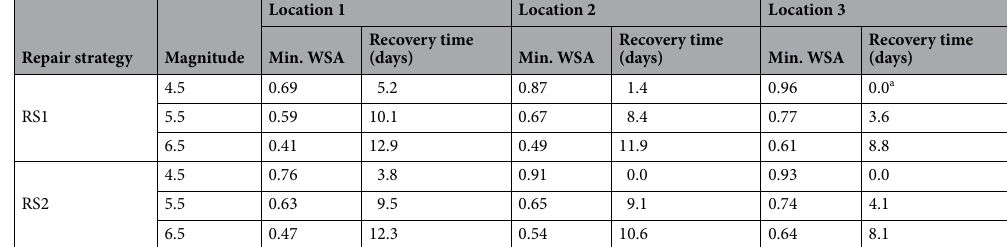
Table 5. Minimum water service availability (WSA) and recovery time for studied earthquake scenarios. Values are computed using the median of the 50 realizations for each scenario. a A recovery time of 0 implies that the median value for WSA never dropped below 90% water service availability.